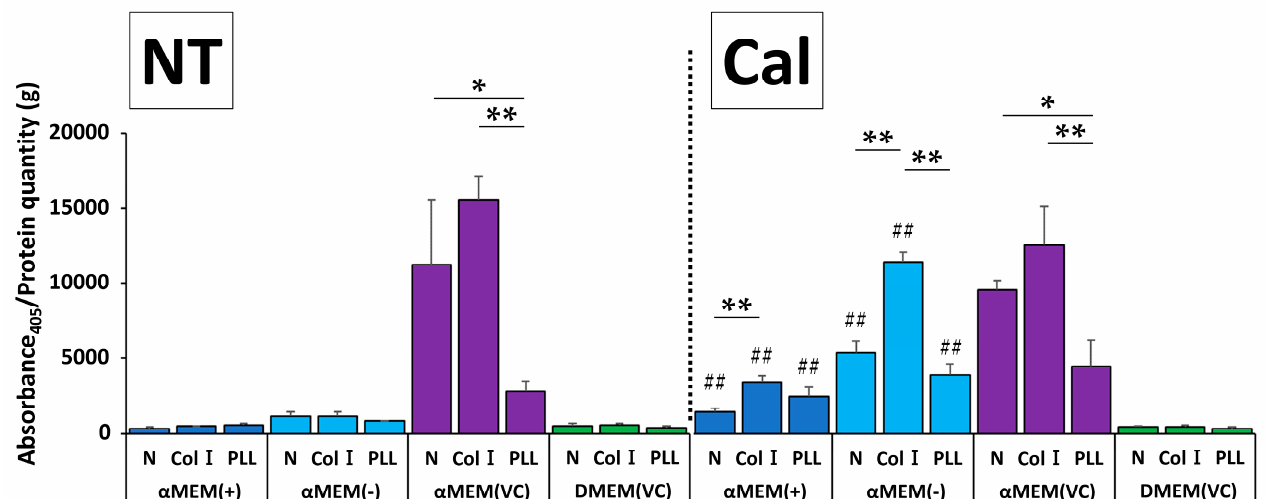
Figure 5. Comparison of alkaline phosphatase (ALP) activity at 7 d after calcification induction using MC3T3-E1 cells in normal (N), Collagen I-coated (Col I), and poly-L-lysine-coated (PLL) culture plates. ALP activity is expressed as Abs 405 /g protein ( n = 3, * p < 0.05, ** p < 0.01, ## p < 0.01): * comparison among plates under the same media conditions; # comparison between two groups of the same type of nontreated (NT) and calcification (Cal) media in each plate.